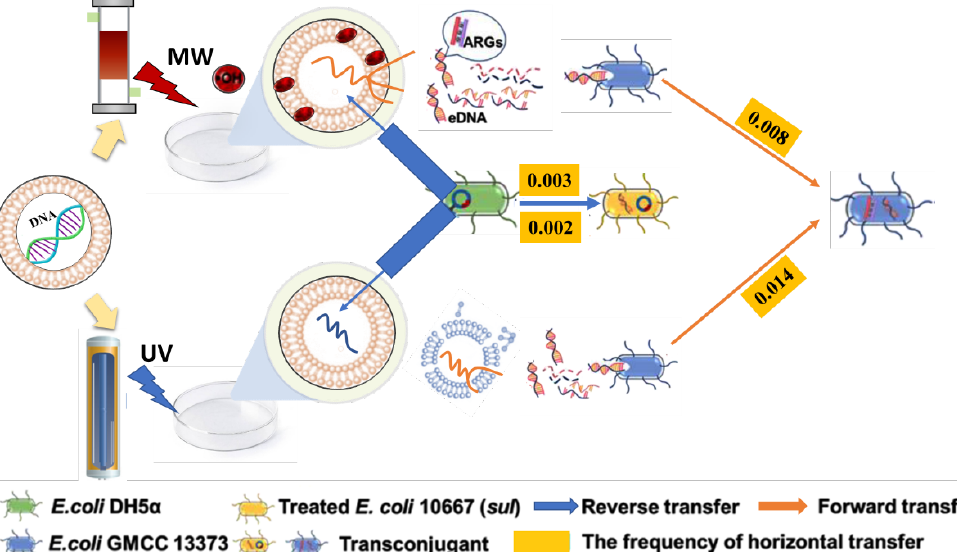
Figure 8. Mechanisms for HGT under MW or UV irradiation. Forward transfer ( E. coli GMCC 13,373 as recipients) and reverse transfer ( E. coli DH5α as donors).